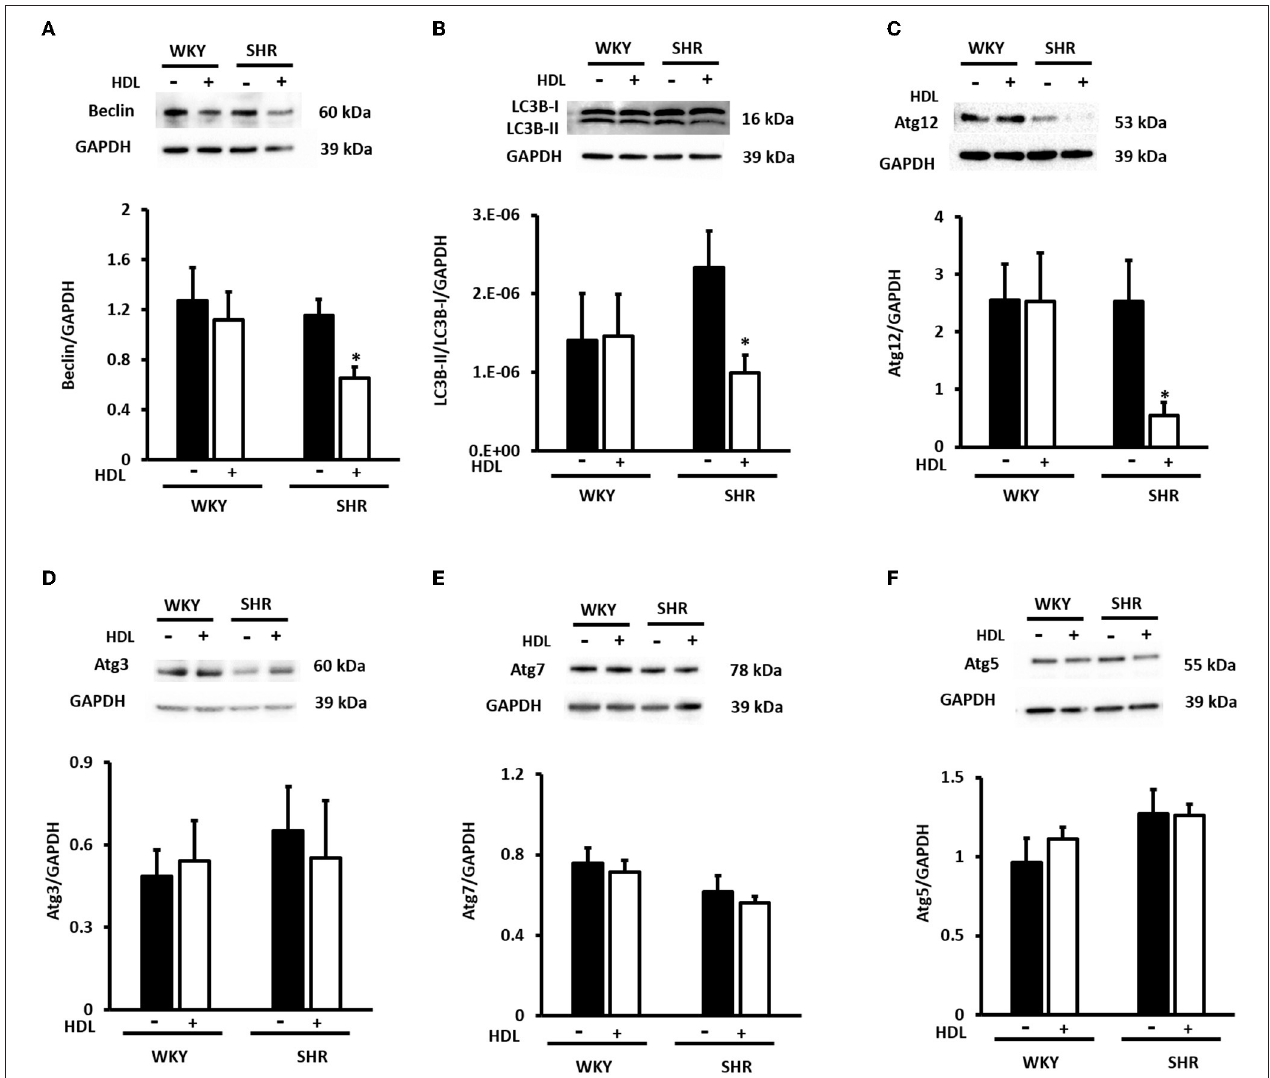
FIGURE 9 | Effect of chronic HDL treatment on the expression of autophagy regulated genes in WKY and SHR. Total heart homogenates were subjected to immunoblotting against beclin, LC3B, Atg-12, Atg-3, Atg-7, Atg-5, and GAPDH as a loading control. Representative images of the relative expression of beclin (A) , LC3B-I and II (B) , Atg-12 (C) Atg-3 (D) , Atg-7 (E) , and Atg-5 (F) in WKY and SHR treated with or without HDL. Data are means ± SEM, * P < 0.05, n = 3–8 rats per